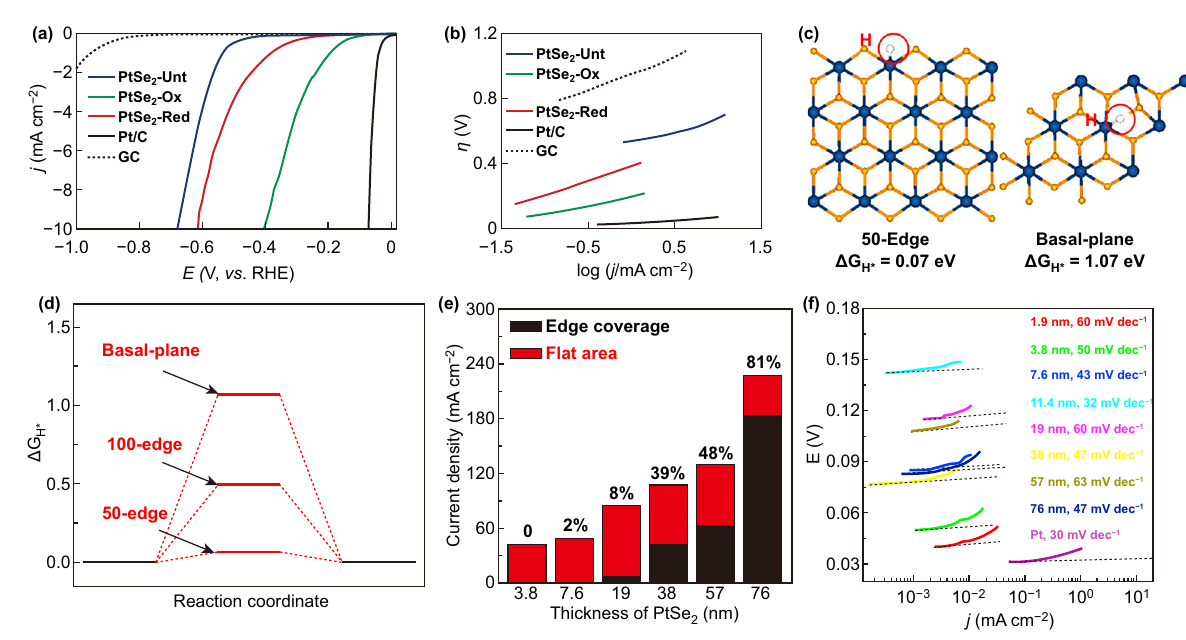
Fig. 14 HER properties of PtSe 2 . a Linear sweep voltammograms versus the reversible hydrogen electrode (RHE) for HER on PtSe 2 , electro‑ chemically oxidized PtSe 2 and electrochemically reduced PtSe 2 . b Tafel plot for PtSe 2 , electrochemically oxidized PtSe 2 and electrochemically reduced PtSe 2 . a , b Reproduced with permission [196]. Copyright 2016, John Wiley and Sons. c Density functional theory theoretical calcula‑ tions of the H adsorption energies at the 50‑edge and basal‑plane of monolayer 1T‑PtSe 2 . White ball: H atom, Blue ball: Pt atom, and yellow ball: Se atom. d Gibbs free energies (ΔG H* ) diagram of different H adsorption states on 1T‑PtSe 2 . c, d Reproduced with permission [197]. Copy‑ right 2019, American Chemical Society. e Relationship between the current density and edge sites density on the top surface of PtSe 2 film and the corresponding f Tafel plots. e–f Reproduced with permission [128]. Copyright 2017,